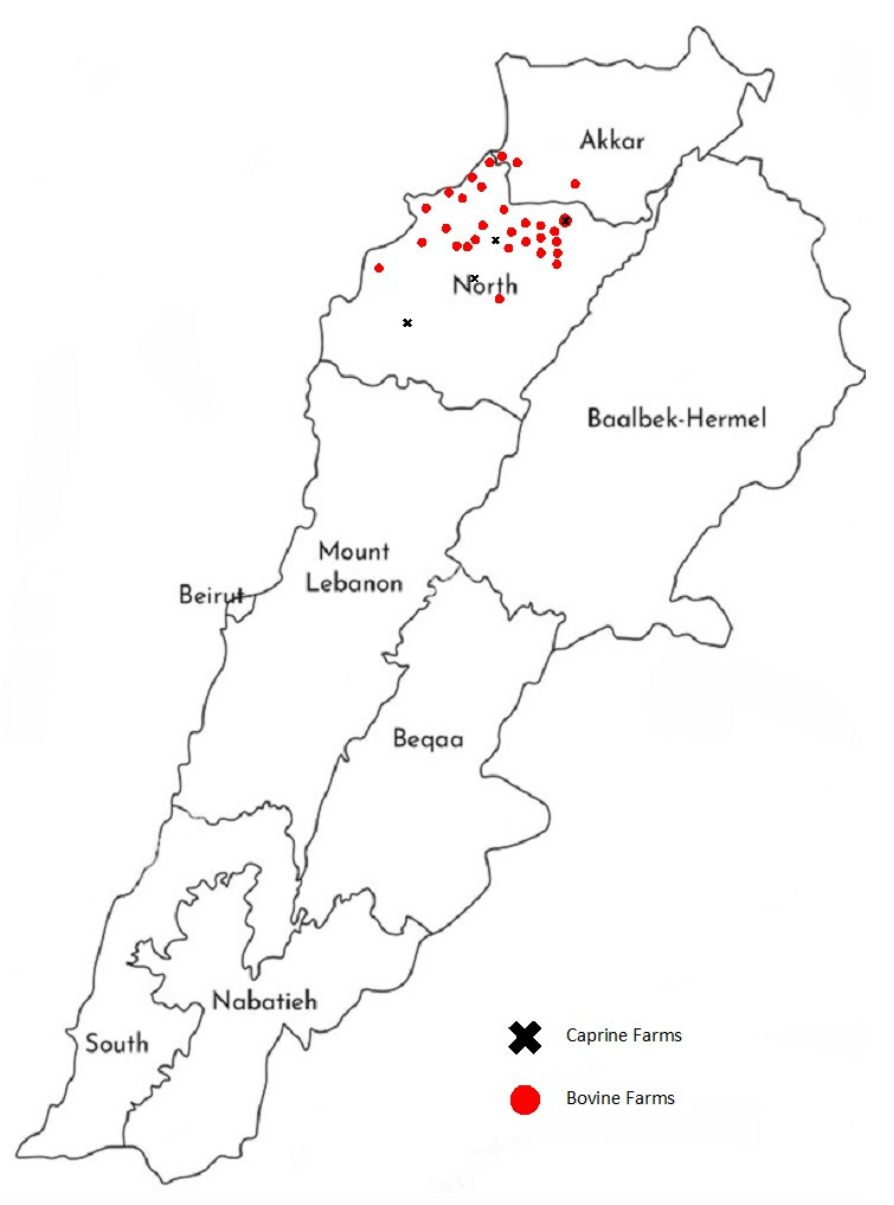
Figure 1. Map of Lebanon displaying the villages in which the dairy farms involved in this study are located.